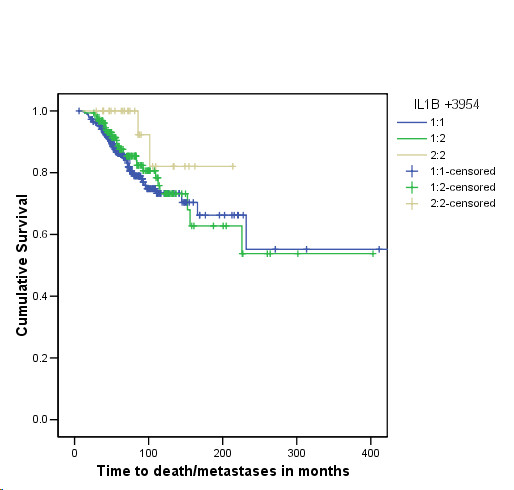
shows the time to death or metastases in invasive breast cancer for the genotypes of the IL1B +3954 polymorphism. Log Rank test statistic = 2.71; df = 2; p = 0.26 (n = 479).